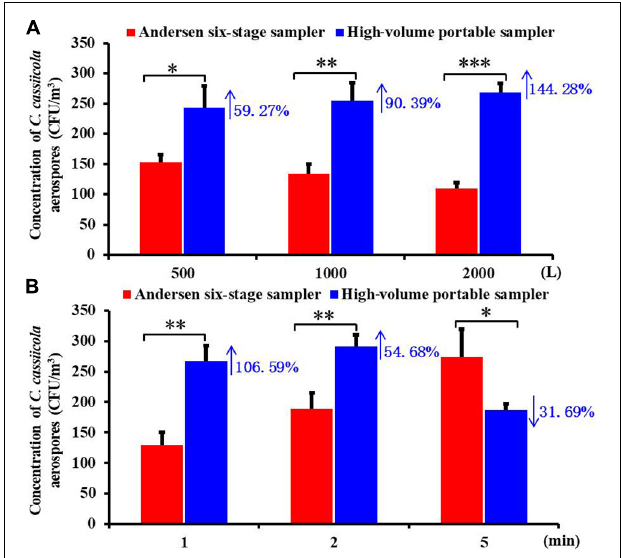
FIGURE 1 | Biological collection efficiencies of Andersen six-stage sampler and high-volume portable sampler with agar plate in sampling the aerospores of aerosolized Corynespora cassiicola (A) under different sampling volumes (500, 1,000, and 2,000 L) and (B) under different sampling times (1, 2, and 5 min) in the exposure chamber. Data points represent averages and standard deviations of three independent sampling experiments; * indicates P < 0.05, ** indicates P < 0.01, and *** indicates P <